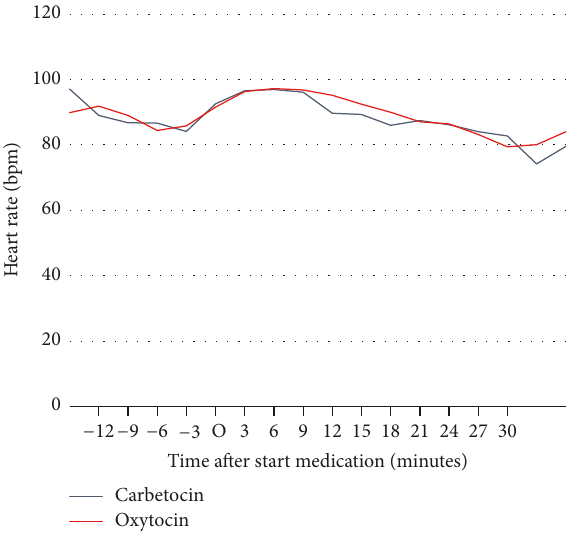
Figure 2: Maternal systolic and diastolic blood pressure from start anaesthesia until the end of the procedure; time point O = start medication; data are displayed as means.